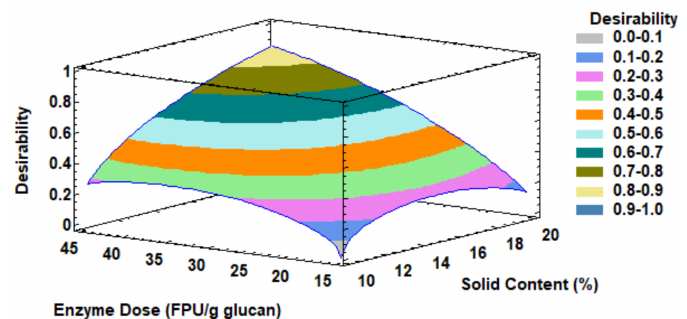
Figure 5. Response surface for desirability function using DM solid consistency and enzyme loading as controlled variables.